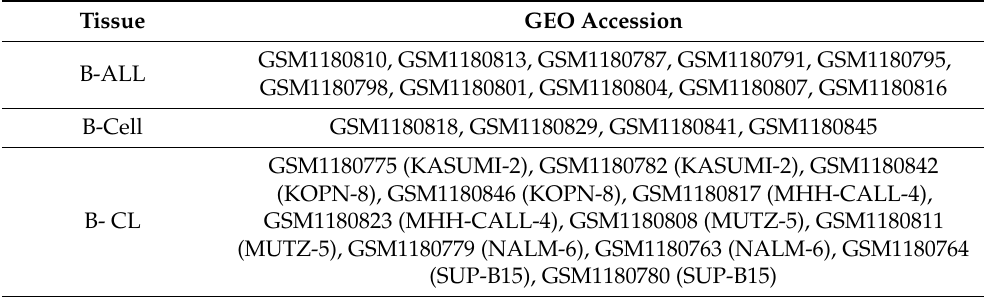
Table 1. Database used in data